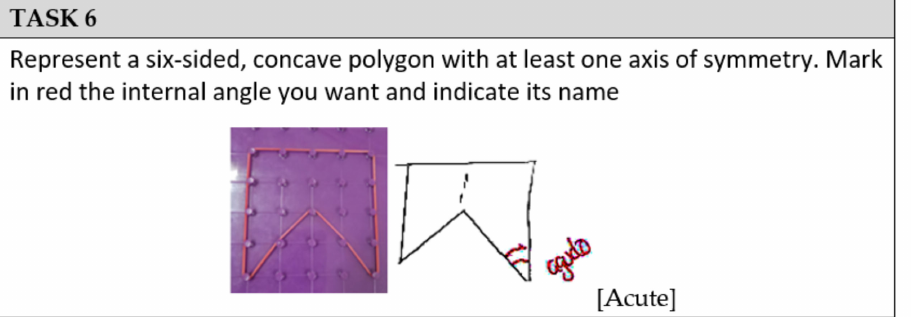
Figure 12. The answer given by student G2S7 when performing the task of constructing and drawing a polygon with conditions.